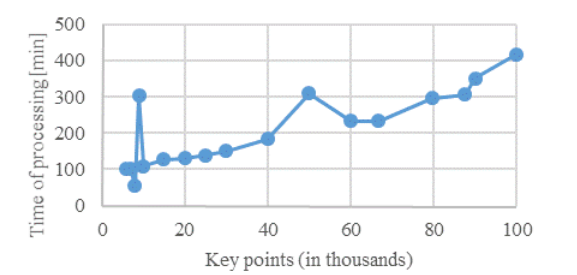
Figure 2. Time of processing (in minutes) in Pix4D of Katowice dataset with different number of key points